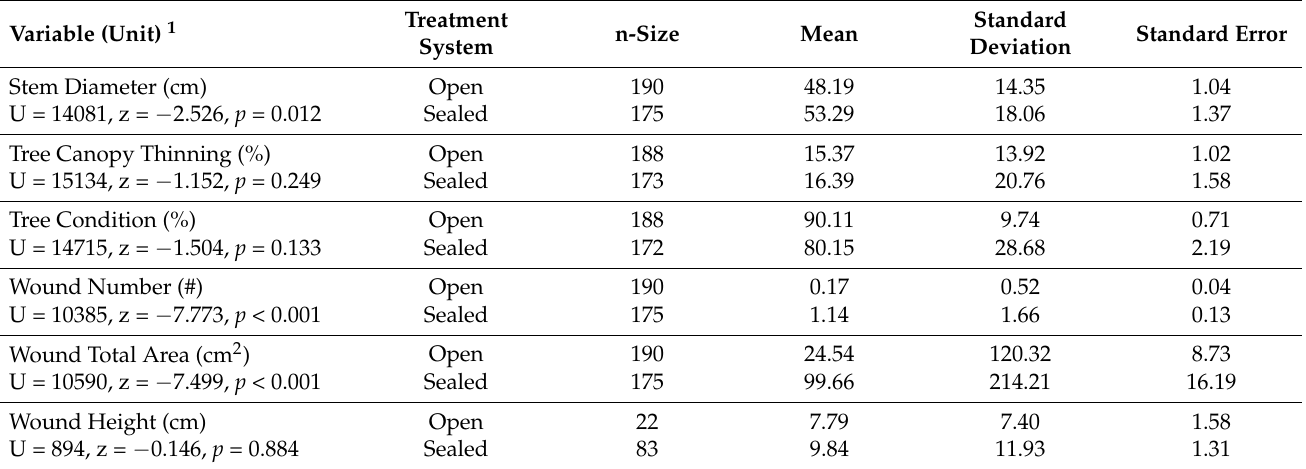
Table 2. Comparison of open (plug-less) and sealed (plug) systems for tree injection for emerald